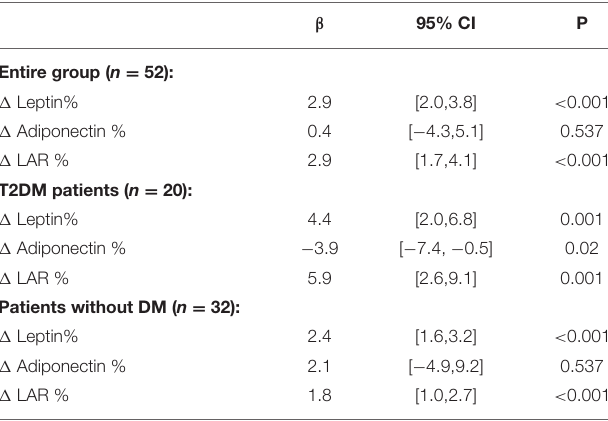
TABLE 2 | Associations between percentage change in weight and percentage change in leptin, adiponectin and the LAR after completion of the milk-based